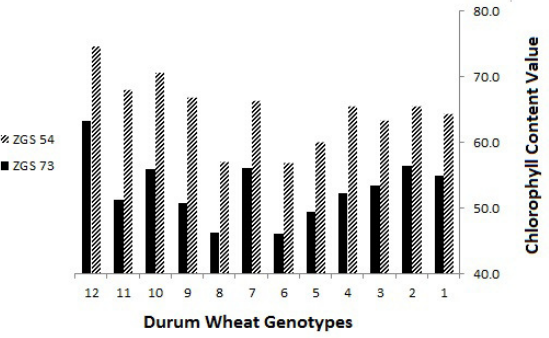
Fig. 5. Canopy temperature depression values of durum wheat genotypes in rain-fed condition